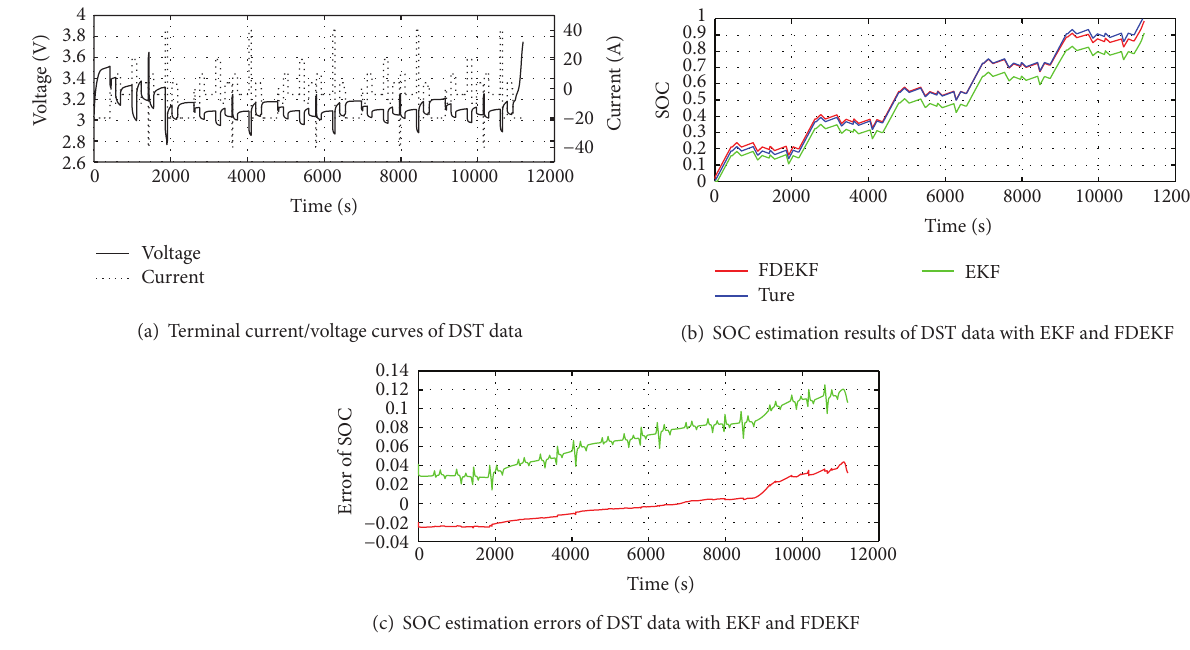
Figure 8: Comparison of SOC estimation and error curve of DST data with EKF and